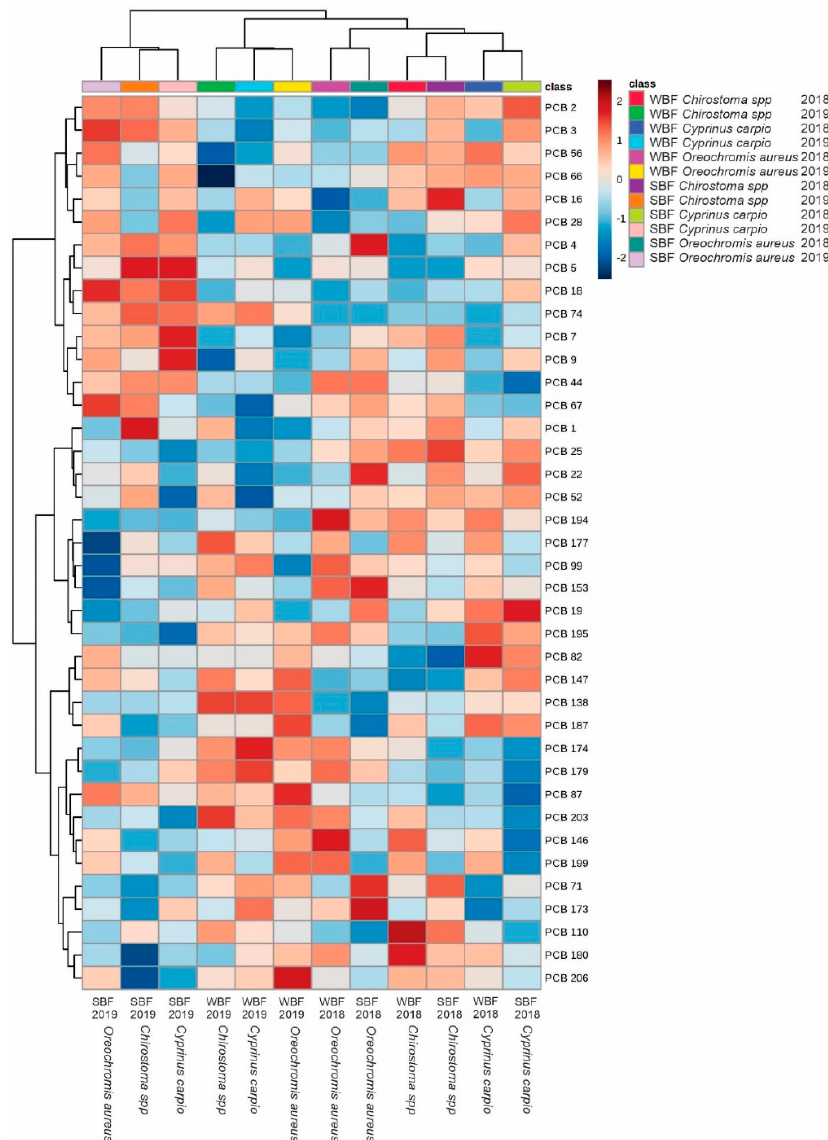
Figure 2. Heat map graph with hierarchical groupings for bioconcentration factors of PCBs in fish from Lake Chapala. In the upper part groupings with respect to the samples. On the left side groupings between analytes. FBS: bioaccumulation factor with respect to sediments. FBA: bioaccumulation factor with respect to water. The color scale represents the normalized bioaccumulation values depending on the samples; an intense red color represents a high value, while an intense blue color represents a low level. Distance measure: Euclidean. Clustering algorithm: ward. t ‐ test/ANOVA.